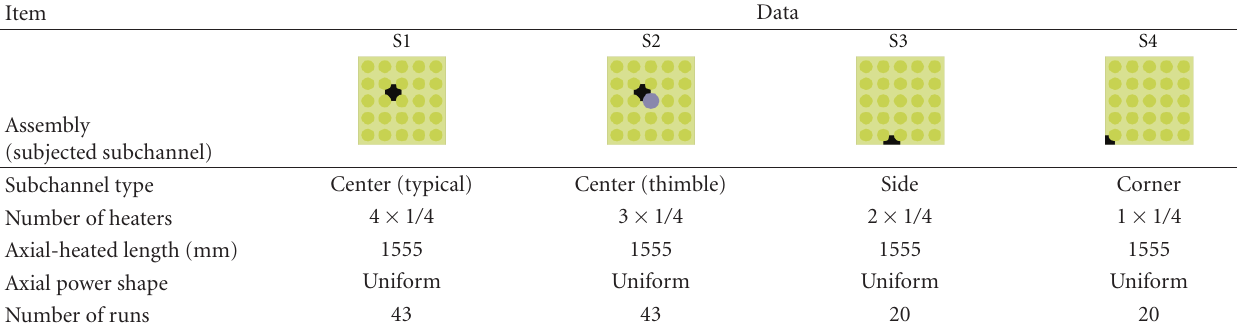
Table 5: Geometry and power shape of rod bundle test assembly (from